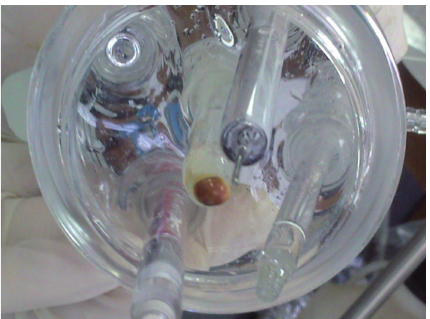
F 1: A photograph showing the three-electrode setup where the visible light red color electrode is the surface of the nanogold electrode